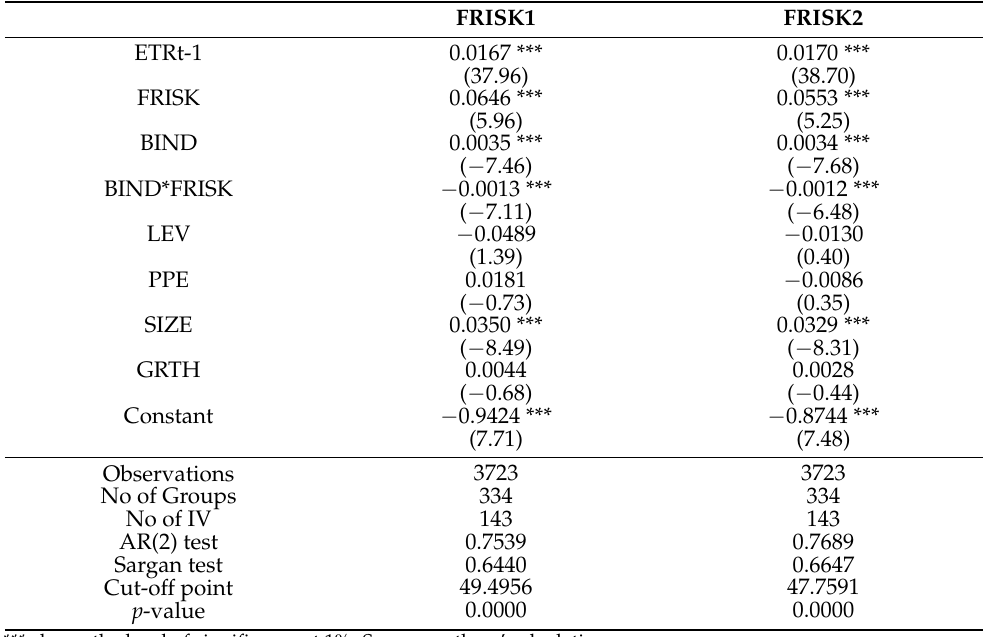
Table 8. The effect of Board independence on the relationship between firm risk and the level of tax avoidance.